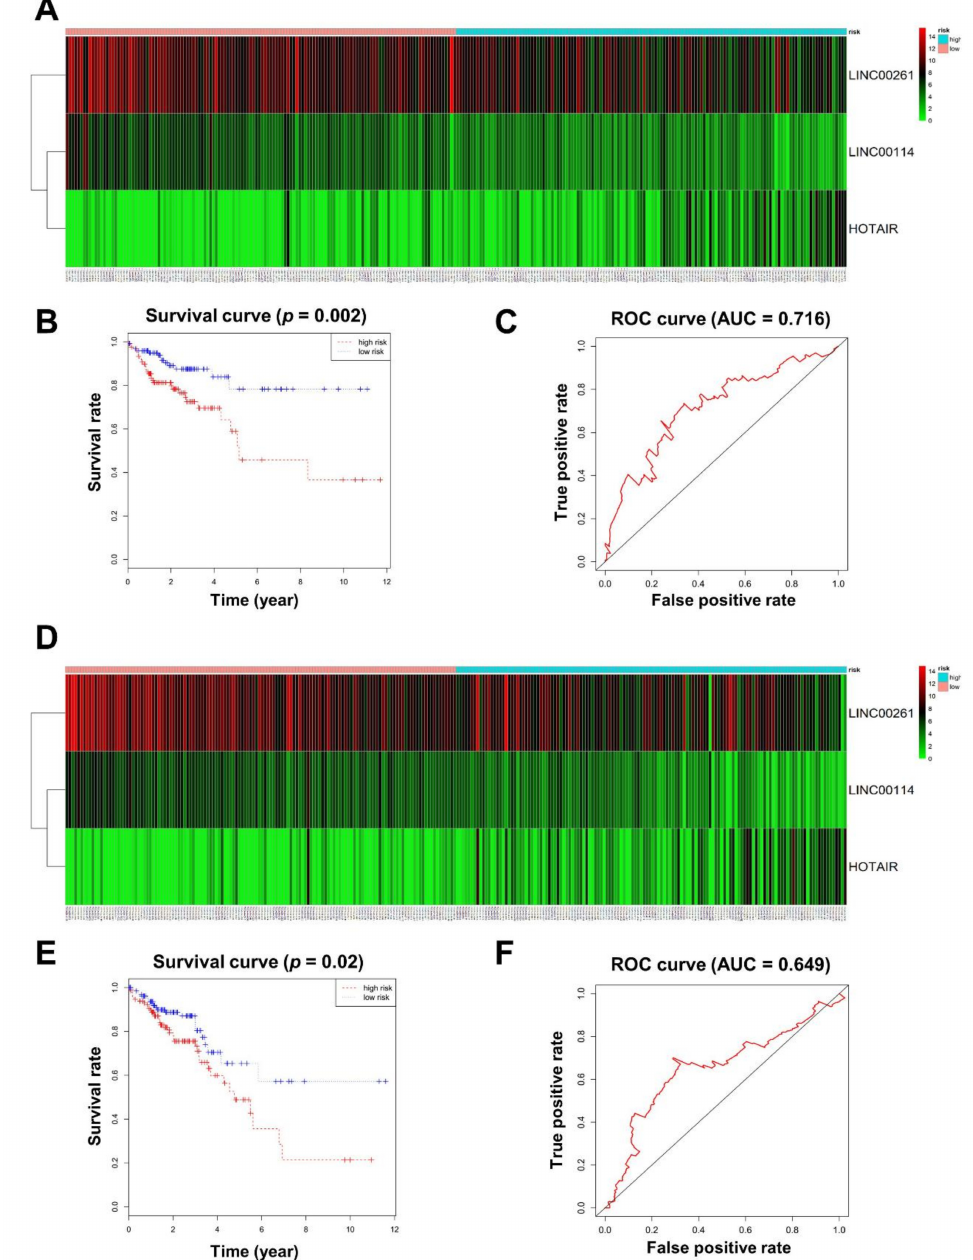
Figure 4. Prognostic evaluation of the 3-lncRNA (long noncoding RNA) signature. ( A ) CRC patients in the training set were divided into high- and low-risk groups using the risk score generated from the 3-lncRNA signature. The heatmap shows the expression profiles of the 3 lncRNAs in CRC patients. Color from green to red indicates an expression level from low to high, respectively. ( B ) The Kaplan–Meier curves of the 3-lncRNA signature for overall survival among CRC patients in the training set ( p = 0.002). ( C ) Receiver operating characteristic (ROC) curve for predicting 5-year survival in CRC patients in the training set based on risk scores. ( D ) CRC patients in the testing set were divided into high- and low-risk groups using the risk score generated from the 3-lncRNA signature. ( E ) The Kaplan–Meier curves of the 3-lncRNA signature for overall survival among CRC patients in the testing set ( p = 0.02). ( F ) ROC curve for predicting 5-year survival in CRC patients in the testing set based on risk